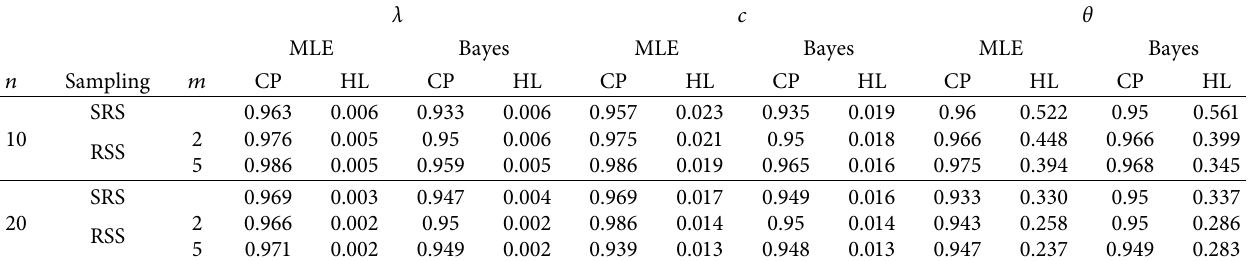
Table 11: Coverage probability and half length of the confidence intervals for the real data